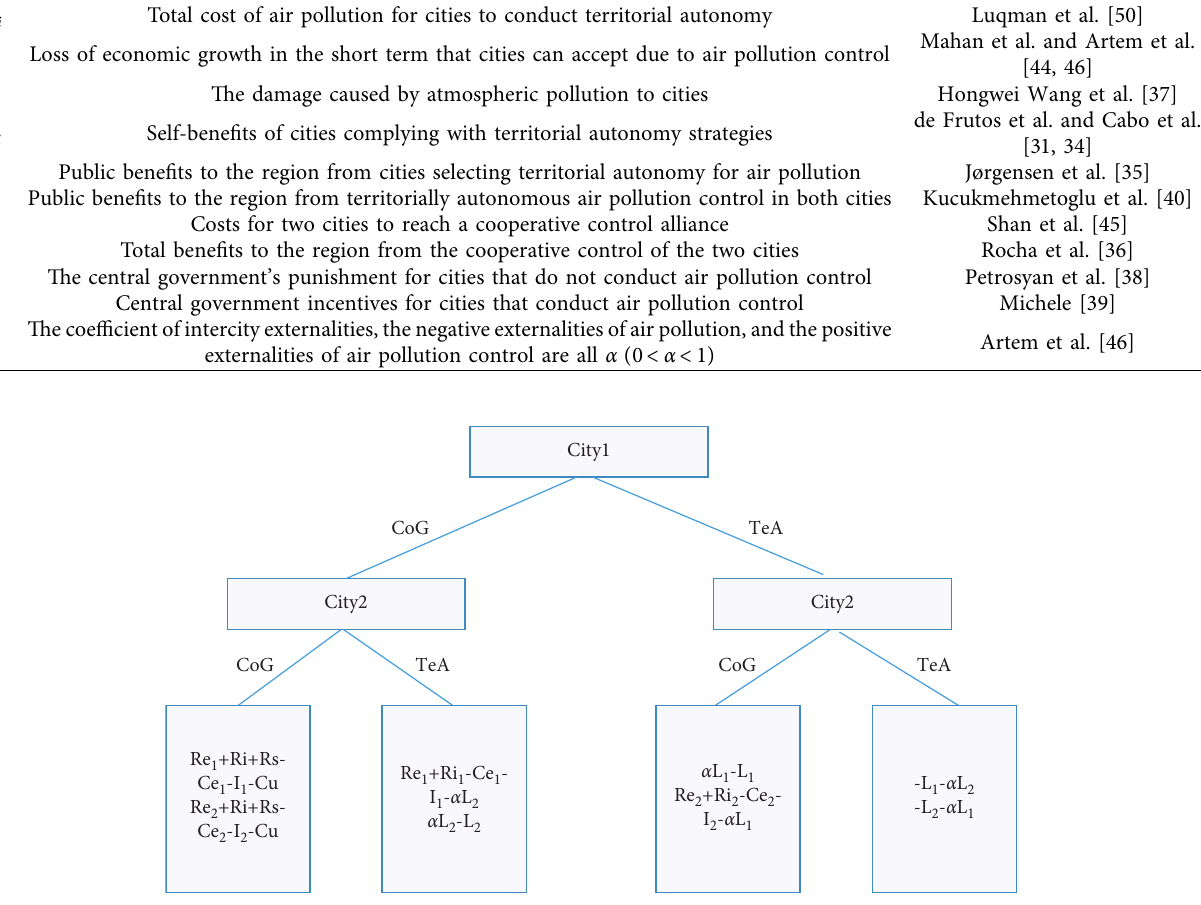
Figure 4: The game tree of city 1 and city 2 without constraints. Note: CoG represents the strategy “cooperative control” and TeA represents “territorial